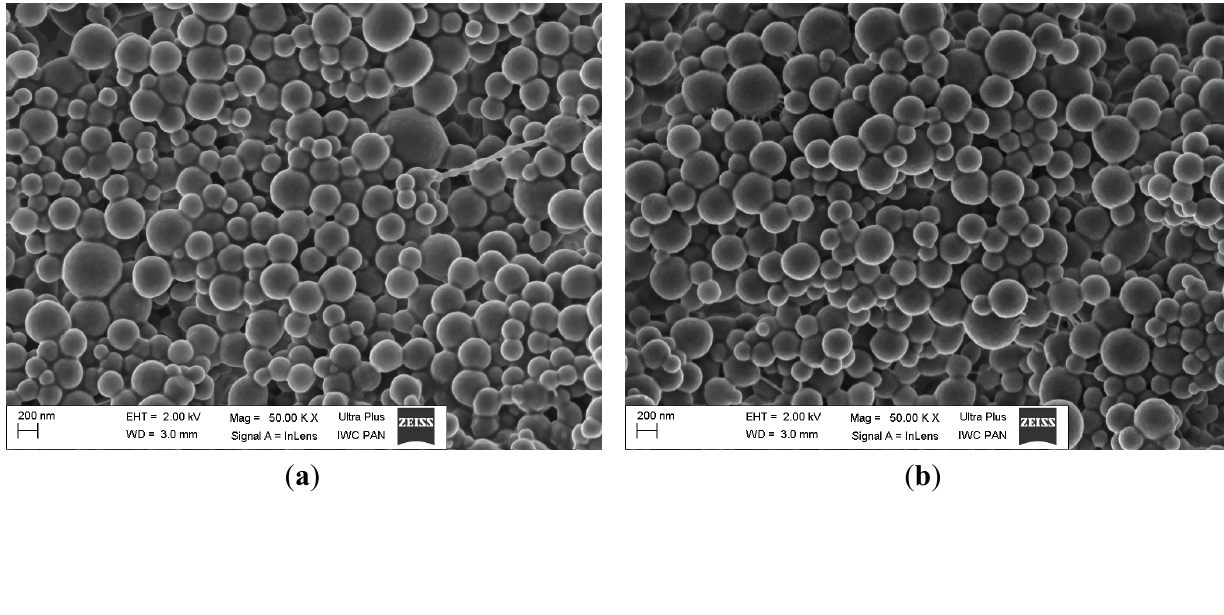
Figure 1. SEM images of PPH-loaded PLGA prepared with PLGA